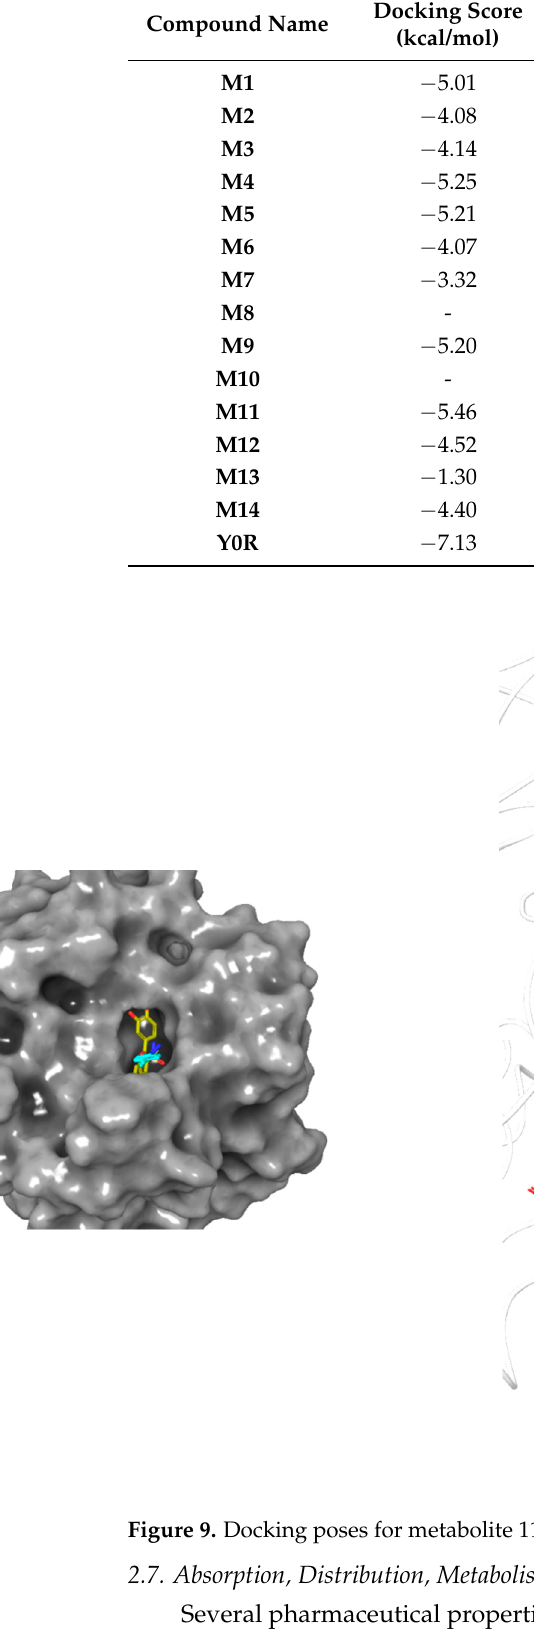
Table 5. Docking scores of identified metabolites with CA IX crystal structure.